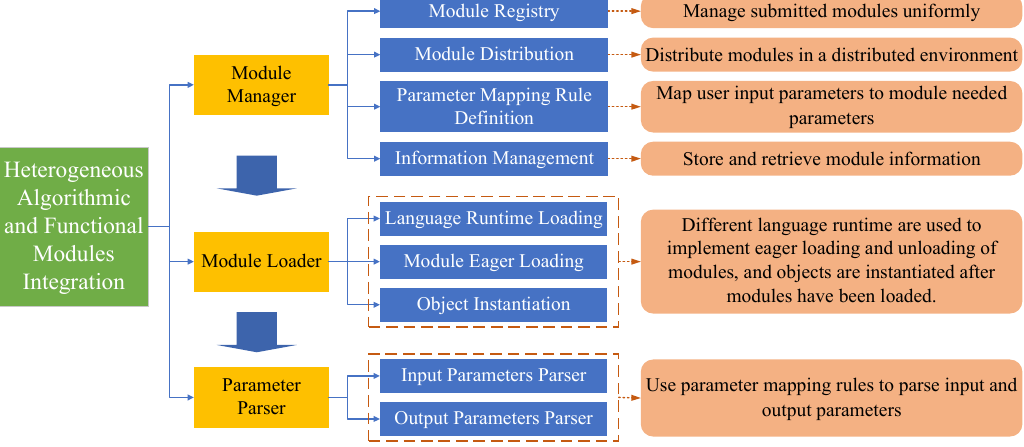
Figure 6. Heterogeneous algorithmic and functional module integration. The combination of module manager, module loader, and parameter parser completes the integration.